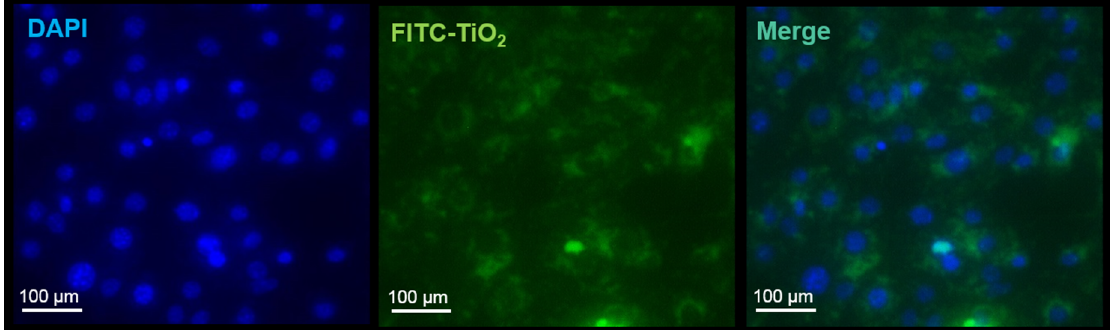
Figure 1. Fluorescence imaging of NIH/3T3 cells incubated with 50 μ g mL − 1 FITC ‐ TiO 2 NPs (green) for 4 h and stained with DAPI (blue). Magnification objective 20 × .